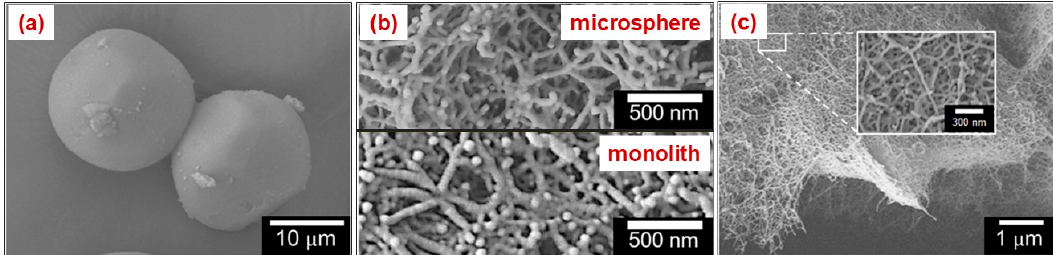
Figure 12. SEM images of: ( a ) PI aerogel microparticles, ( b ) their skeletal networks in comparison with corresponding monoliths, and ( c ) the surface of PI aerogel microparticles. Adapted with permission from Ref. [54]. Copyright 2016 American Chemical Society.